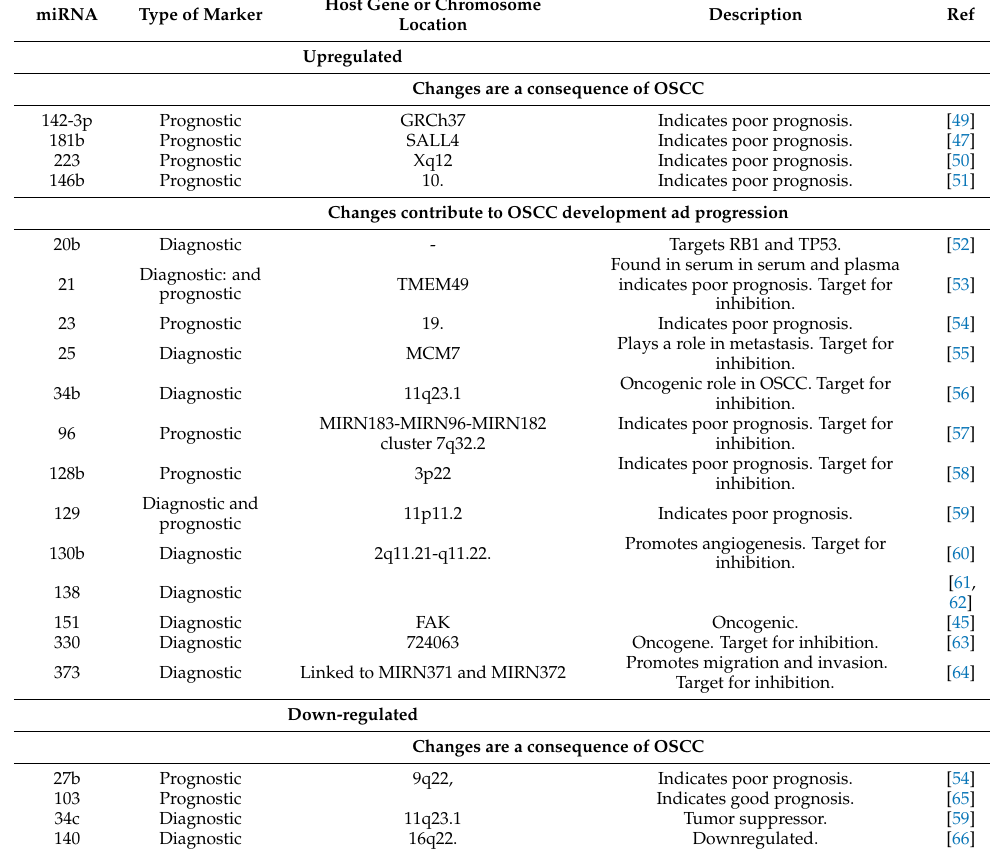
Table 3. miRNAs that can be used as biomarkers in oesophageal cancers.